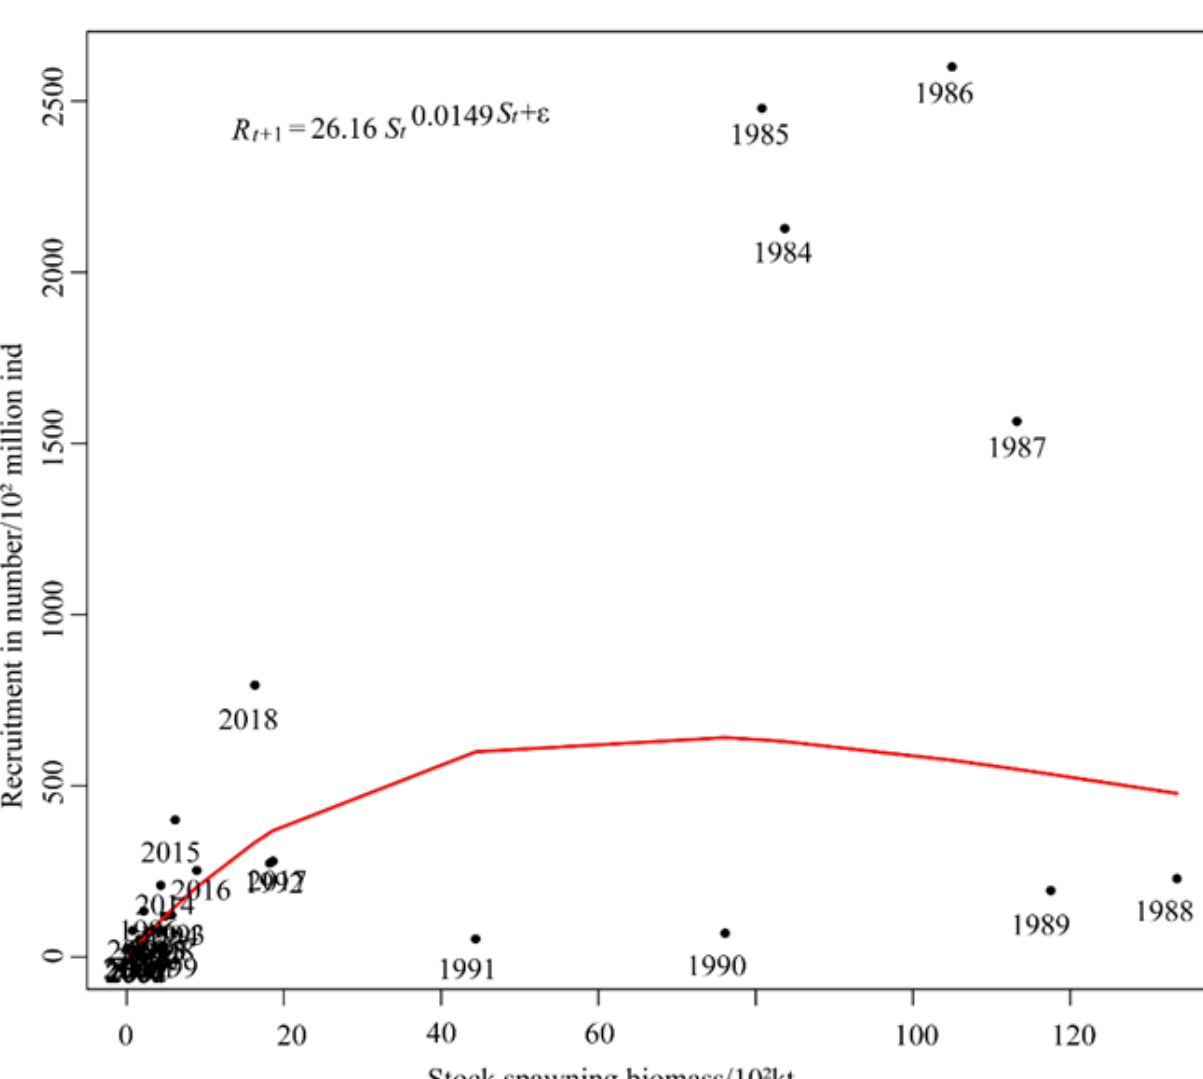
Table 2. Results of the best Ricker-E model with the addition of environmental factors in different numbers. Formula Variable Intercept